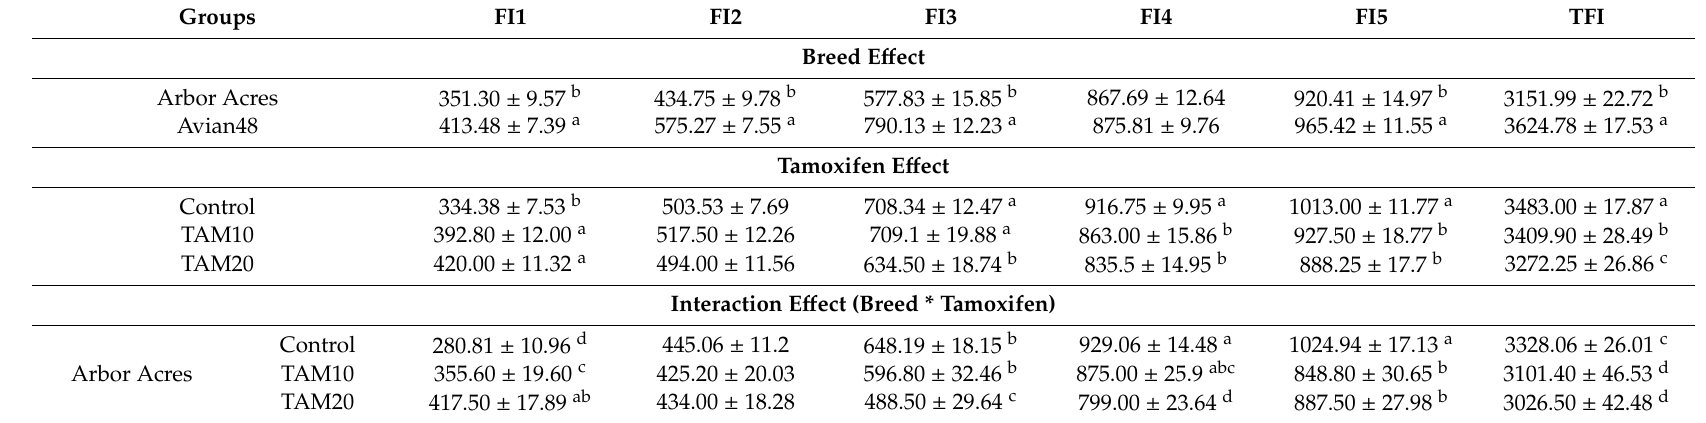
Table 4. The e ff ect of breed, Tamoxifen treatments and their interactions on weekly feed intake (Means ±